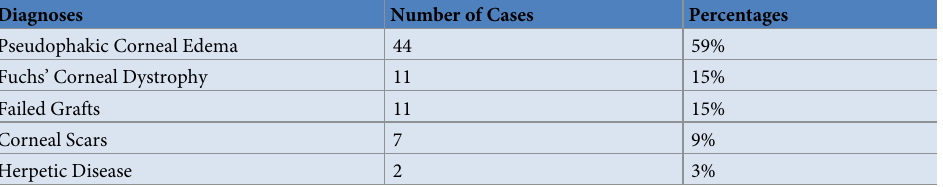
Table 1. Underlying pre-operative